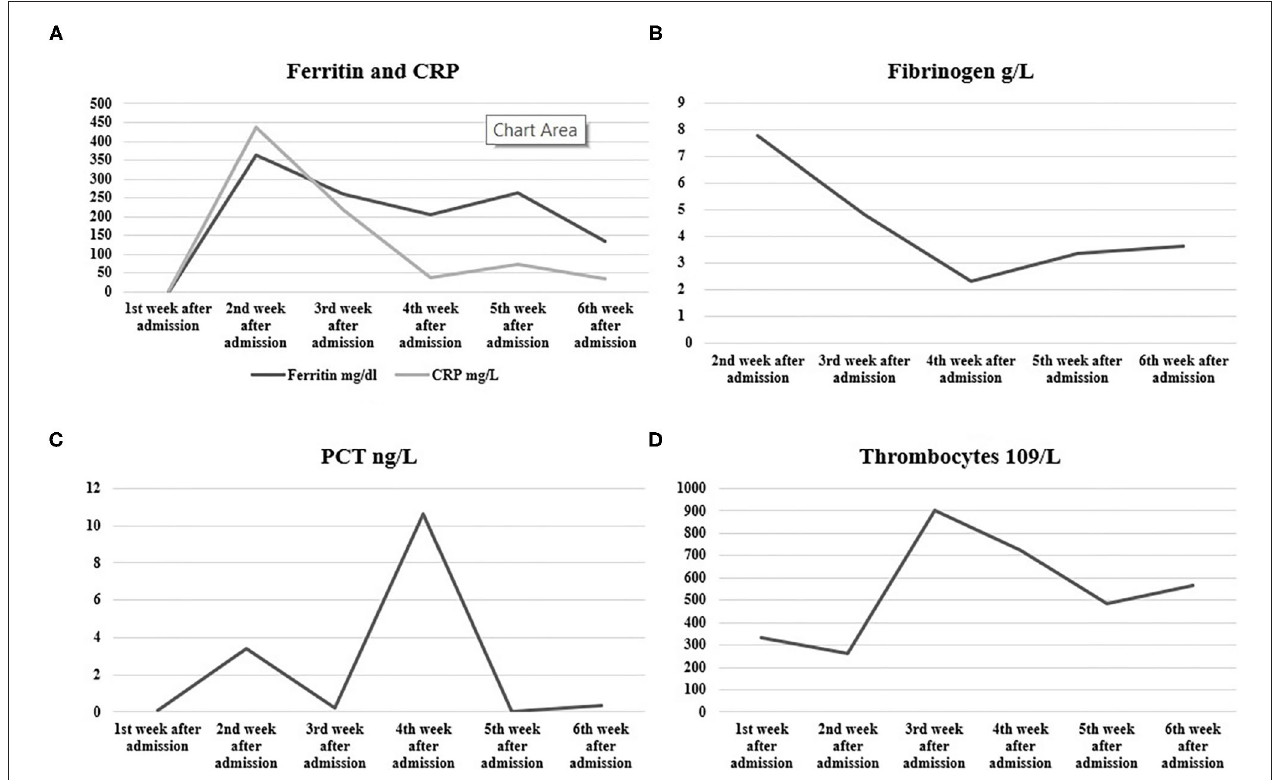
FIGURE 2 | Dynamics of (A) C-reactive protein (CRP) and Ferritin, (B) fibrinogen, (C) procalcitonin (PCT), and (D) thrombocytes during the course of the